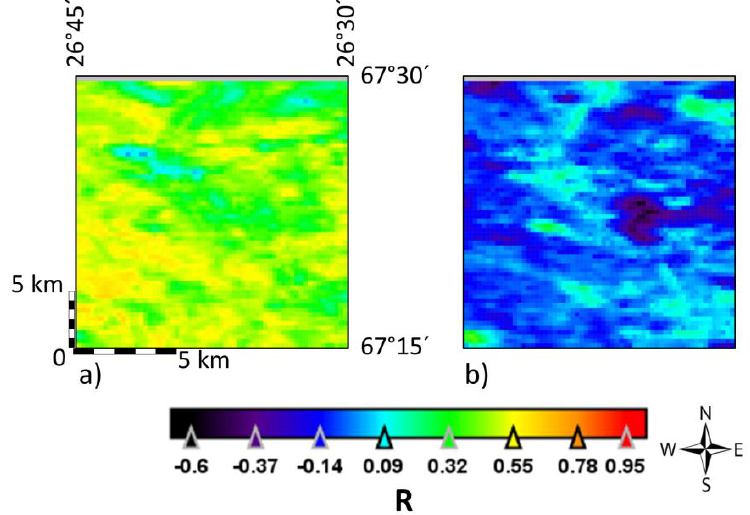
Figure 9. ( a ) ASAR SM vs. ECV SM and ( b ) ASAR SM vs. in situ SM correlation maps evaluated for each ASAR WS pixel (1 km × 1 km after resampling) within the Sodankylä (FMI) ECV size